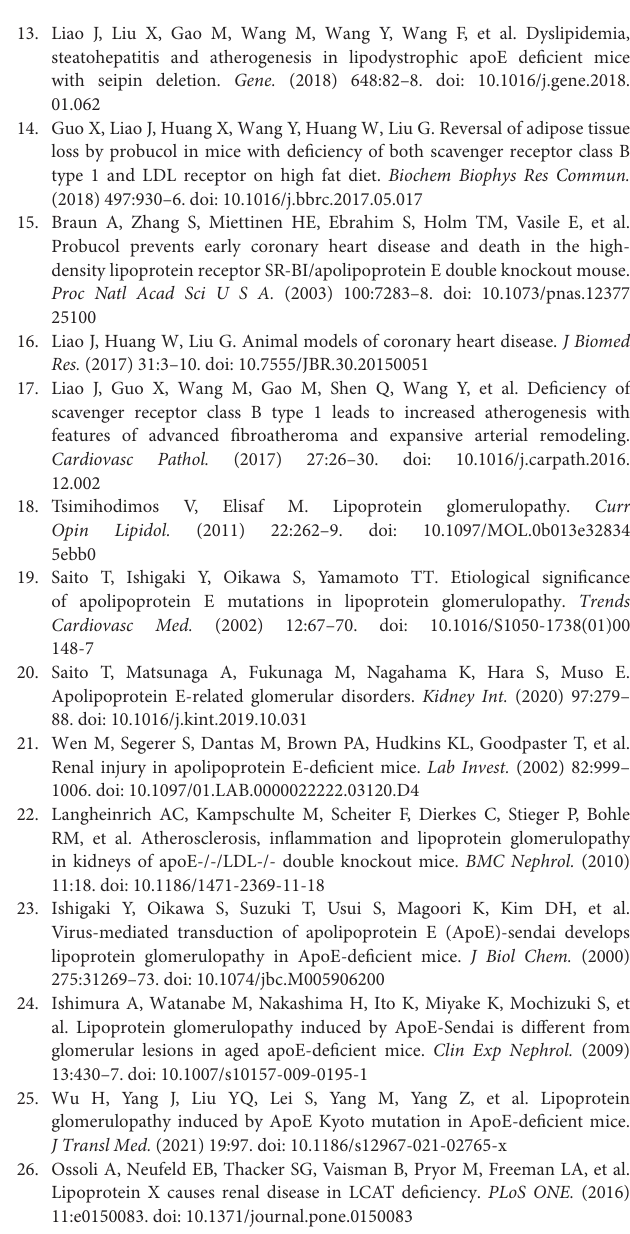
Supplementary Figure 2 | Quantification of renal cholesterol (left) and triglycerides (right) content in Srb1/Ldlr-/- and Ldlr-/- mice fed on HFD. n = 4 per group. ∗∗ : p < 0.01; ns: no significance. Supplementary Figure 3 | Representative Mac2-stained glomeruli of HFD-fed Srb1/Ldlr-/- mice and Ldlr-/- controls. The triangles indicate intraglomerular Mac2-positive macrophage clusters. Supplementary Figure 4 | Representative H&E-stained glomeruli of HFD-fed male Srb1/Ldlr-/- mice. The triangles indicate LPG-like lesions. Supplementary Figure 5 | Representative ORO-stained glomeruli of chow-fed Srb1/Apoe-/- mice died prematurely from spontaneous myocardial